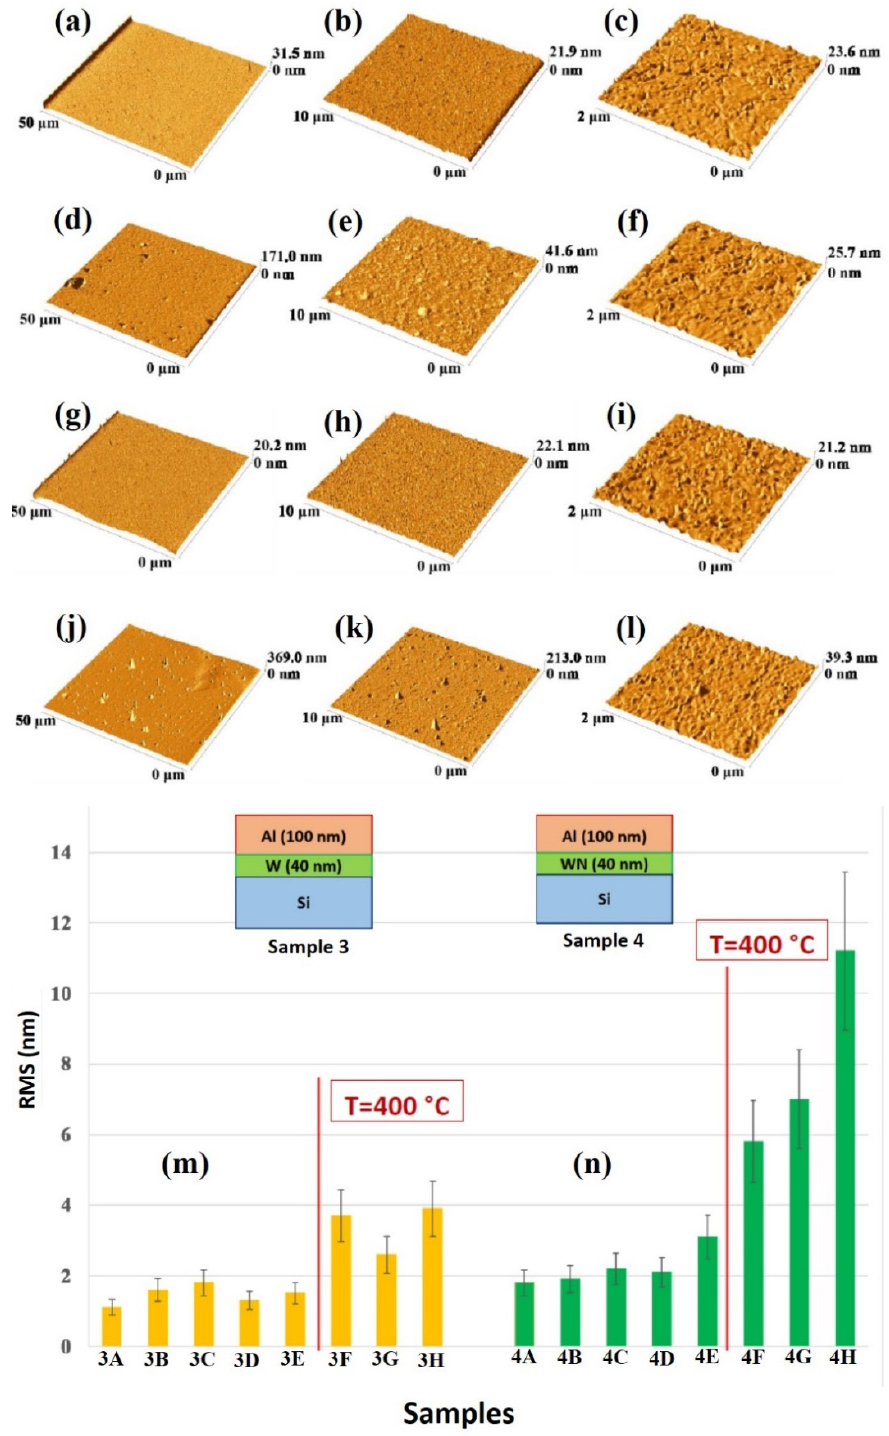
Figure 9. Representative AFM images (three-dimensional reconstructions) of the Al surface for the sample: ( a – c ) 3A (Si/W/Al) with decreasing scan size from ( a ) to ( c ); ( d – f ) 3H (Si/W/Al + 500 °C 15 min) with decreasing scan size from ( d ) to ( f ); ( g – i ) 4A (Si/WN/Al) with decreasing scan size from ( g ) to ( i ); ( j – l ) 4H (Si/WN/Al + 500 °C 15 min) with decreasing scan size from ( j ) to ( l ). ( m ) reports the Al layer surface roughness, as quantified by RMS through the AFM measurements and calculated by the 50 µ m scan size images, for samples of class 3 (Si/W/Al) in the various thermal processing conditions. ( n ) reports the Al layer surface roughness, as quantified by RMS through the AFM measurements and calculated by the 50 µ m scan size images, for samples of class 4 (Si/WN/Al) in the various thermal processing conditions.